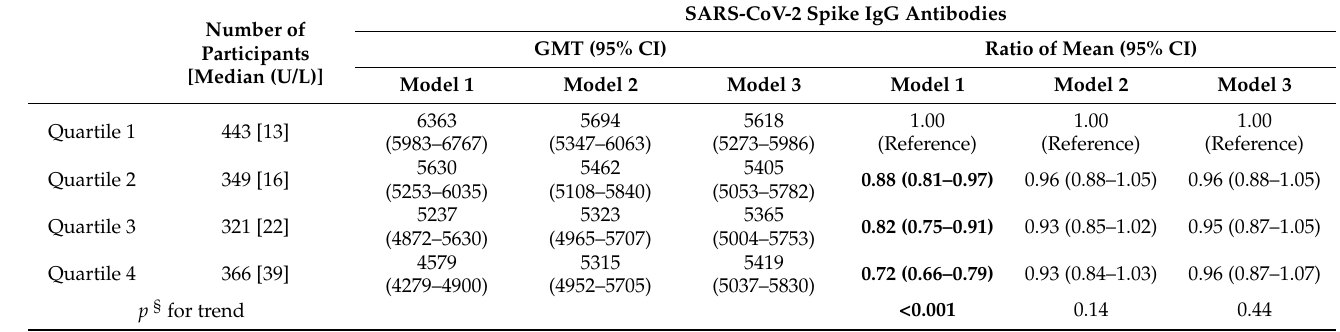
Table 3. Geometric mean (GMT) (95% CI) and ratio of mean (95% CI) SARS-CoV-2 spike antibody titers for each of the γ -glutamyl transpeptidase level quartiles (according to the Japan Society of Ningen Dock,